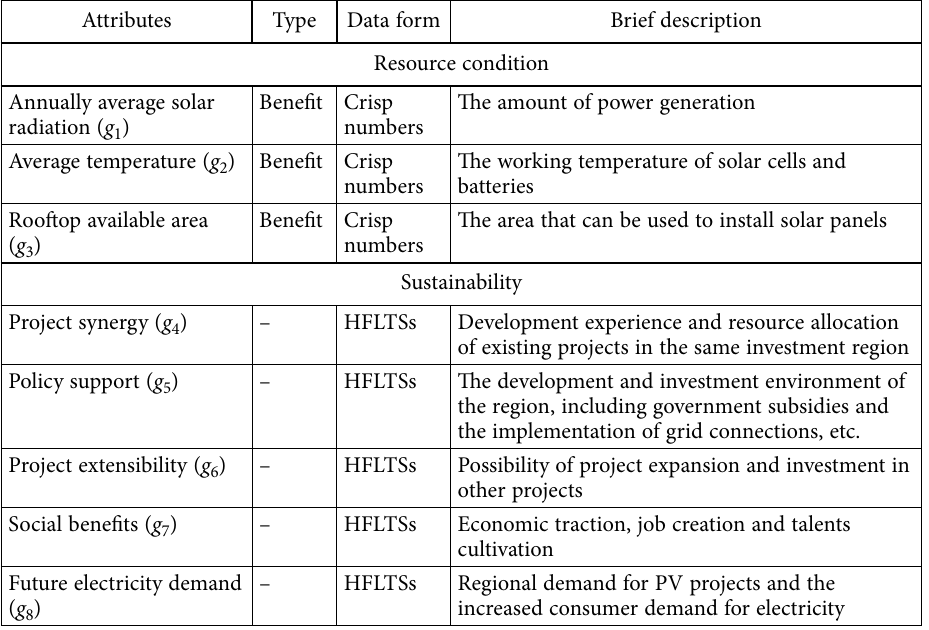
Table 2. Attributes to evaluate the non-financial value of projects